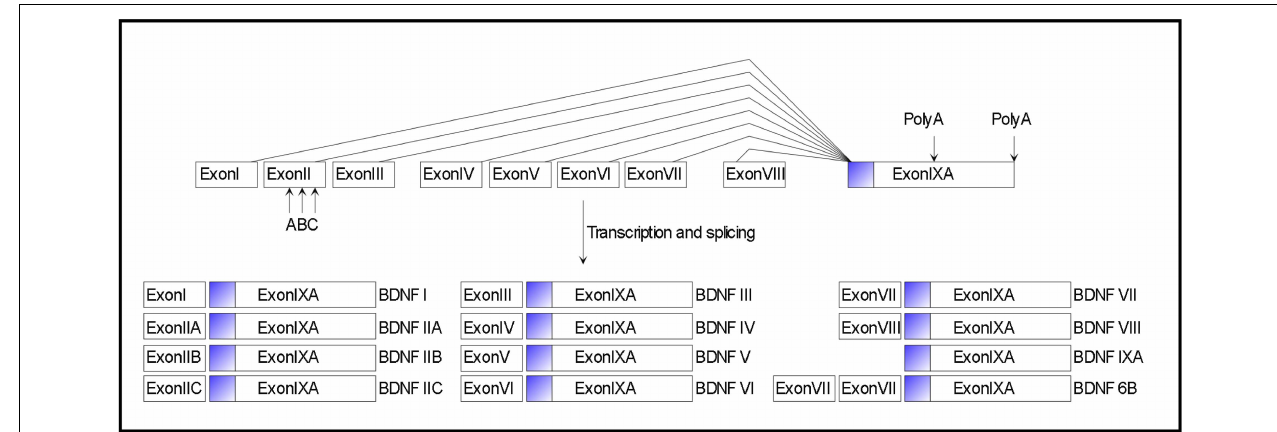
promoters, immediately preceding each of the 5 ′ exons (exons I–VIII), so that each full-length transcript contains a unique 5 ′ -exon and a common 3 ′ -exon (exon IXA) that encodes the BDNF protein. Transcript BDNF6B results from splicing events that incorporate exons VII, VIII and